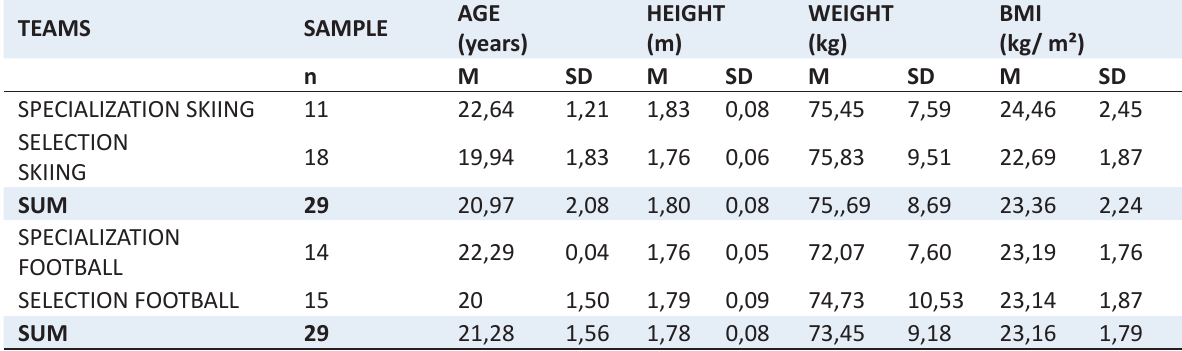
Table 1. Anthropometric characteristics of skiers and footballers